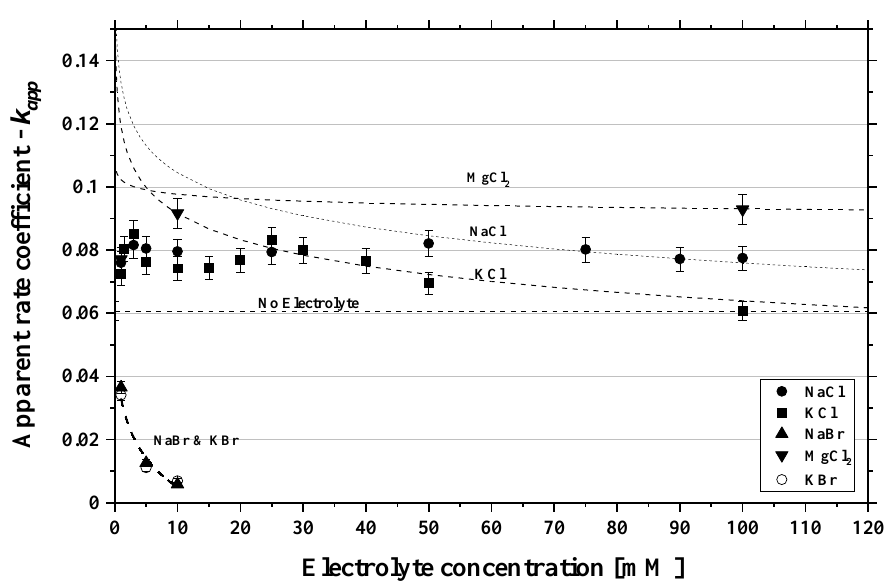
Figure 2. Apparent rate coefficients ( k app ) as a function of low electrolytes concentrations (<120 mM). (electrolytes are represented by different symbols). Dashed plots represent a logarithmic regression fitting as described by the equations in Figure 2.